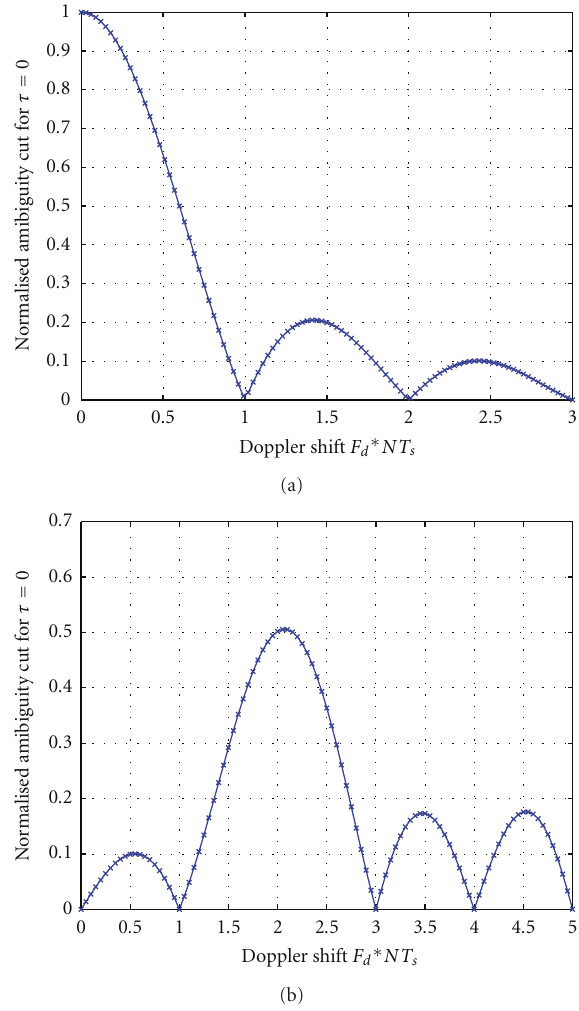
Figure 4: Doppler shift of 124-length ZCZPS ( τ = 0): (a) autocorrelation (b)